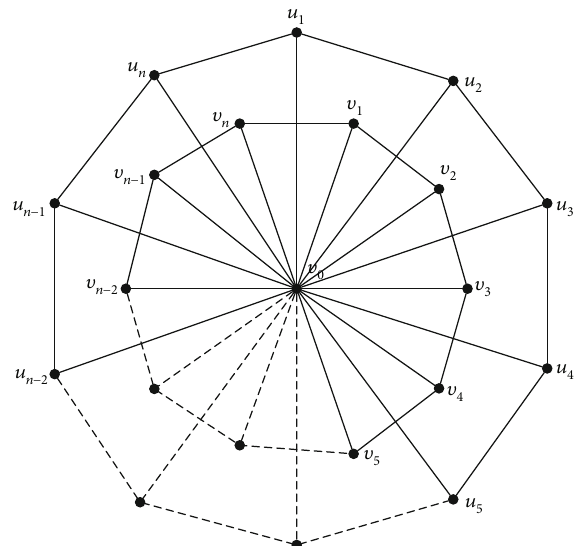
Figure 4: An alternate triangular cycle A ð C graceful labeling.